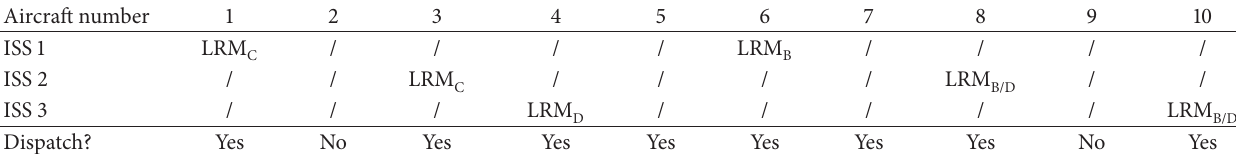
Table 3: The optimal scheme for aircraft fleet CBM and